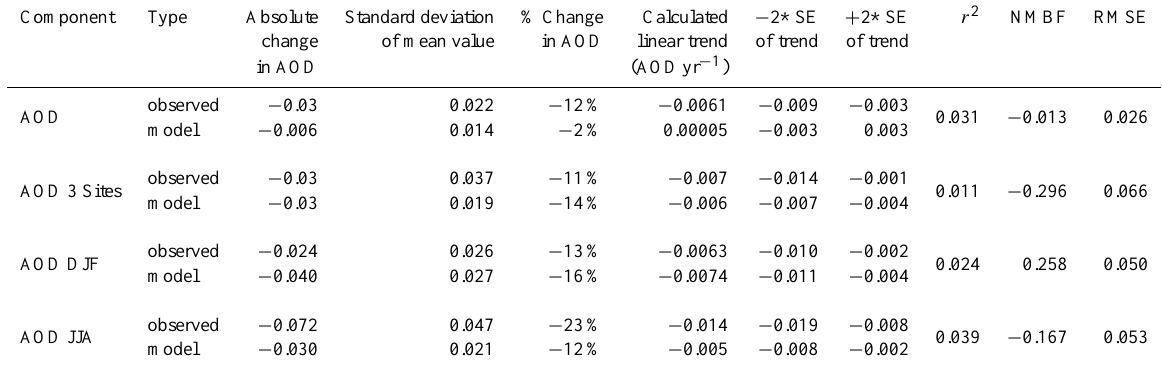
Table 4. Statistical summary of modelled and observed annual and seasonal (DJF and JJA) mean AOD at all long-term ( > 7 years of data) measurement sites (13 sites) between 2000 and 2009. A similar comparison is presented at the three measurement locations that contain annual mean observations throughout every year between 2000 and 2009 (AOD , three sites). Absolute and relative (%) changes in concentrations are calculated as the difference between the mean of the initial 5 years of data minus the mean of the last 5 years of data. Trends that are above or below the value of twice of the standard error of the trend (95% confidence) are highlighted in bold.